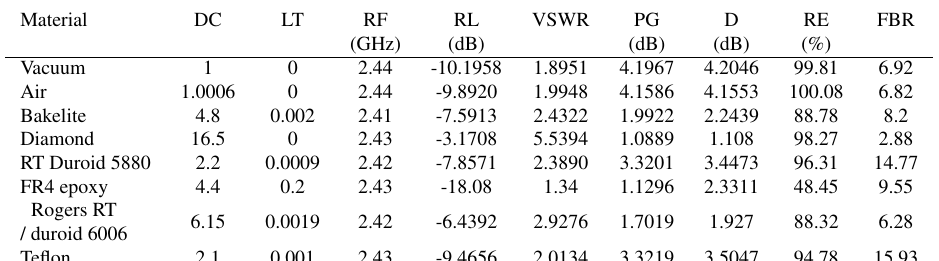
Table 3: AHP: Step1